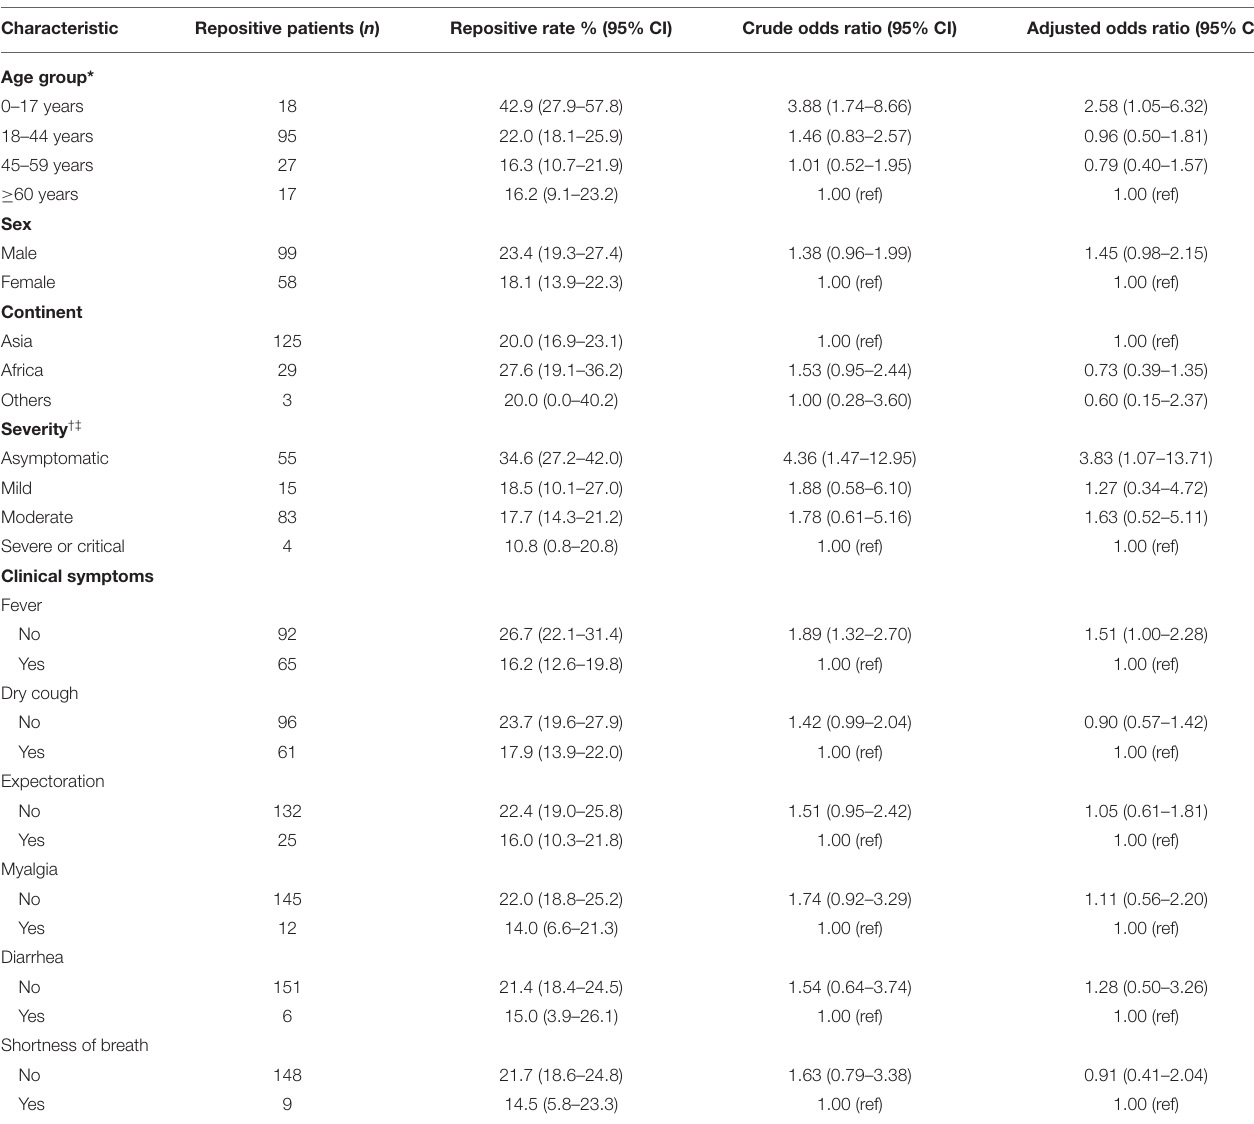
TABLE 3 | Risk factors associated with re-positivity among COVID-19 patients ( n =